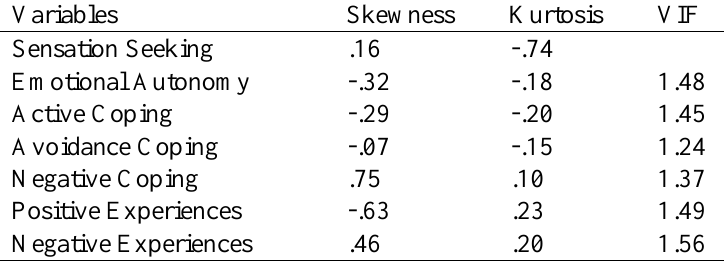
Findings of Regression Analysis Assumptions